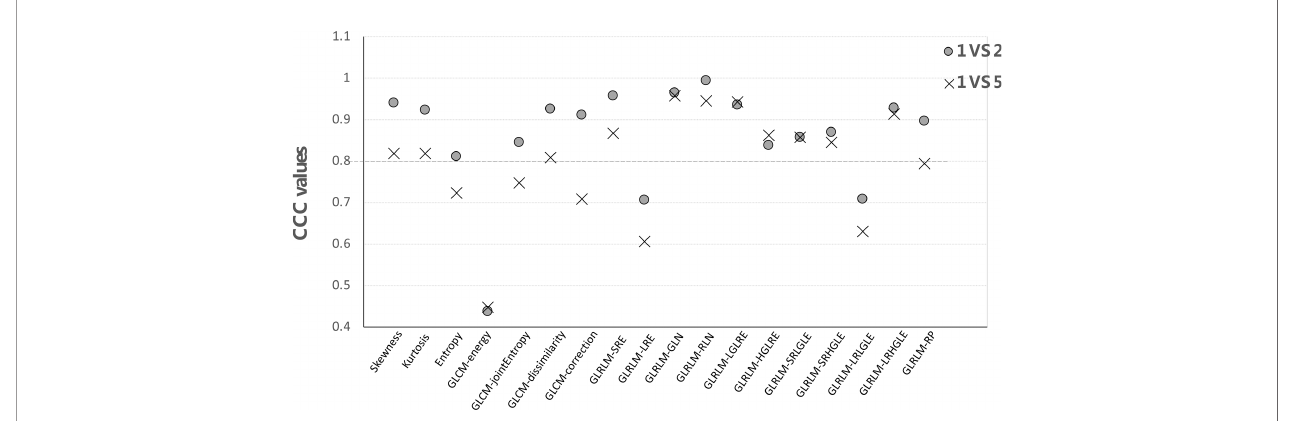
FIGURE 5 | The CCC values of each feature by comparing the fi rst- vs . second-day and fi rst- vs . fi fth-day